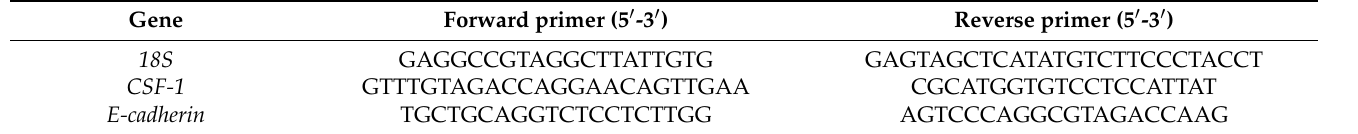
Table 1. List of primers used in real-time